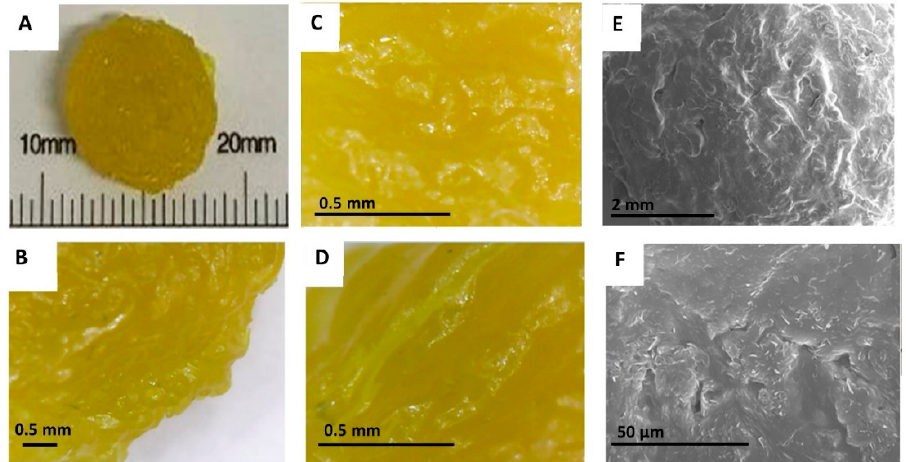
Figure 2. Morphology of NFD 3D printed minitablets. ( A ) Full NFD 3D printed minitablet; ( B ) Image of the 3D printed minitablet side obtained by the digital microscope at 50 magnification. ( C ) Image of the 3D printed minitablet central surface obtained by digital microscope at 100 magnification; ( D ) Image of the 3D printed minitablet side obtained by digital microscope at 100 magnification; ( E , F ) Micrographs obtained by Scanning Electronic